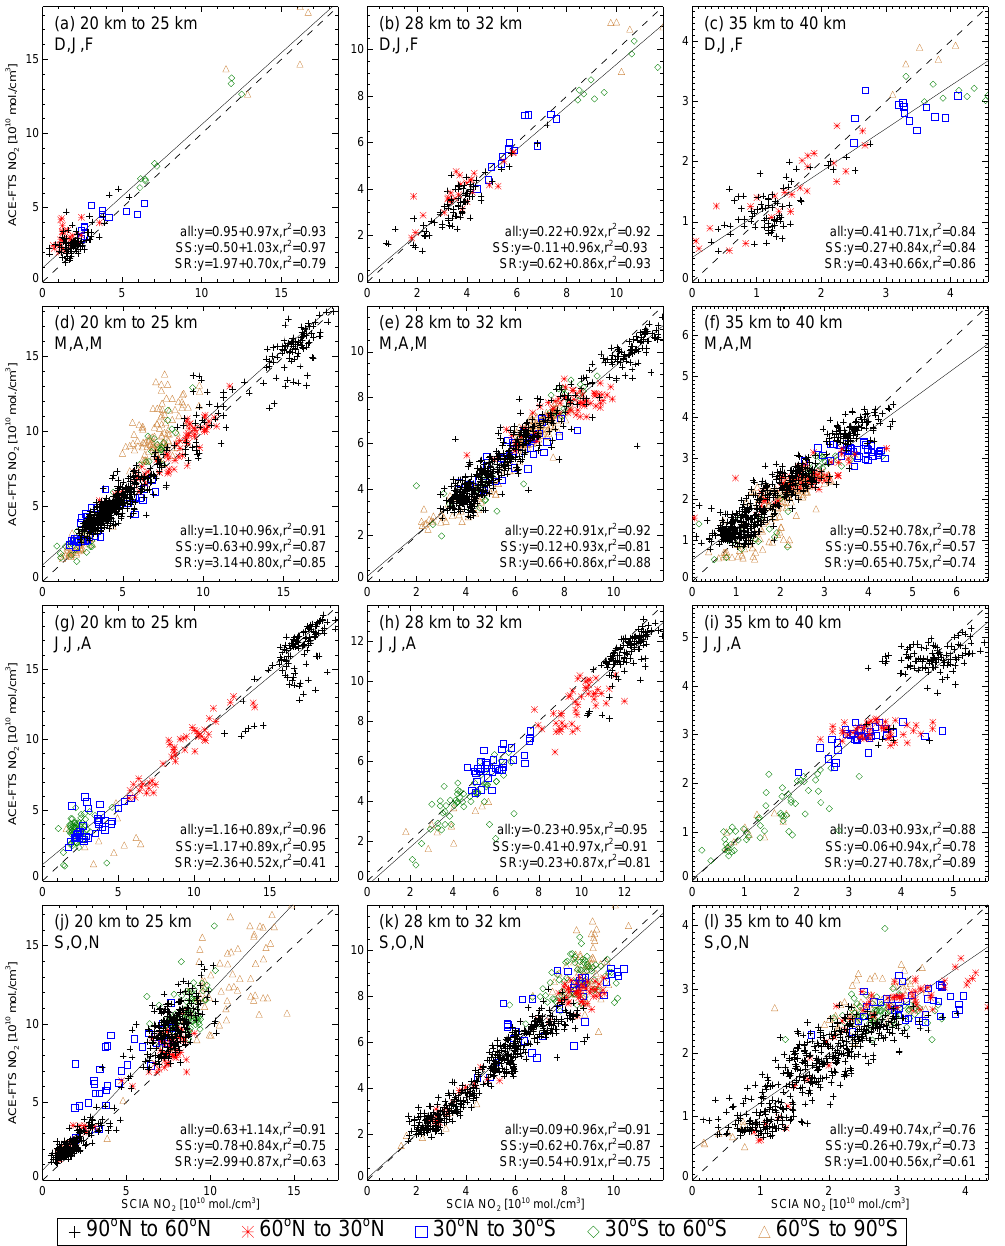
Fig. 14. Same as Fig. 8, but for ACE-FTS. Data sets from the years 2004 and 2005 are shown in this figure. 1668 collocation pairs are shown (817 for ACE-FTS sunset and 851 for